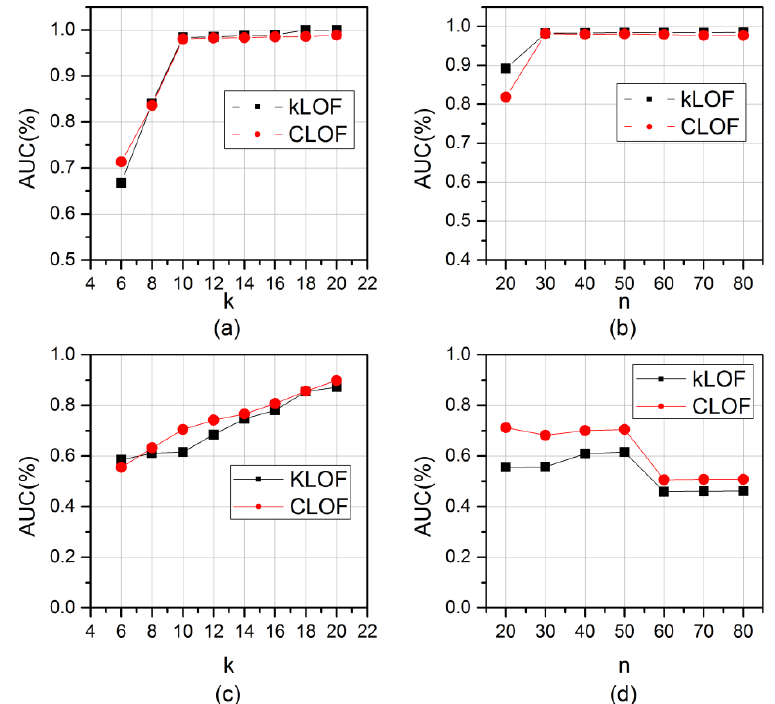
Figure 18. AUC values of kLOF and CLOF methods on the LWSNDR dataset: ( a ) the AUC values of kLOF and CLOF methods with different k and n = 50 on the multi-hop outdoor moteid1 dataset; ( b ) the AUC values of kLOF and CLOF methods with different n and k = 10 on the multi-hop outdoor moteid1 dataset; ( c ) the AUC values of kLOF and CLOF methods with different k and n = 50 on the multi-hop indoor moteid3 dataset; ( d ) the AUC values of kLOF and CLOF methods with different n and k = 10 on the multi-hop indoor moteid3 dataset.